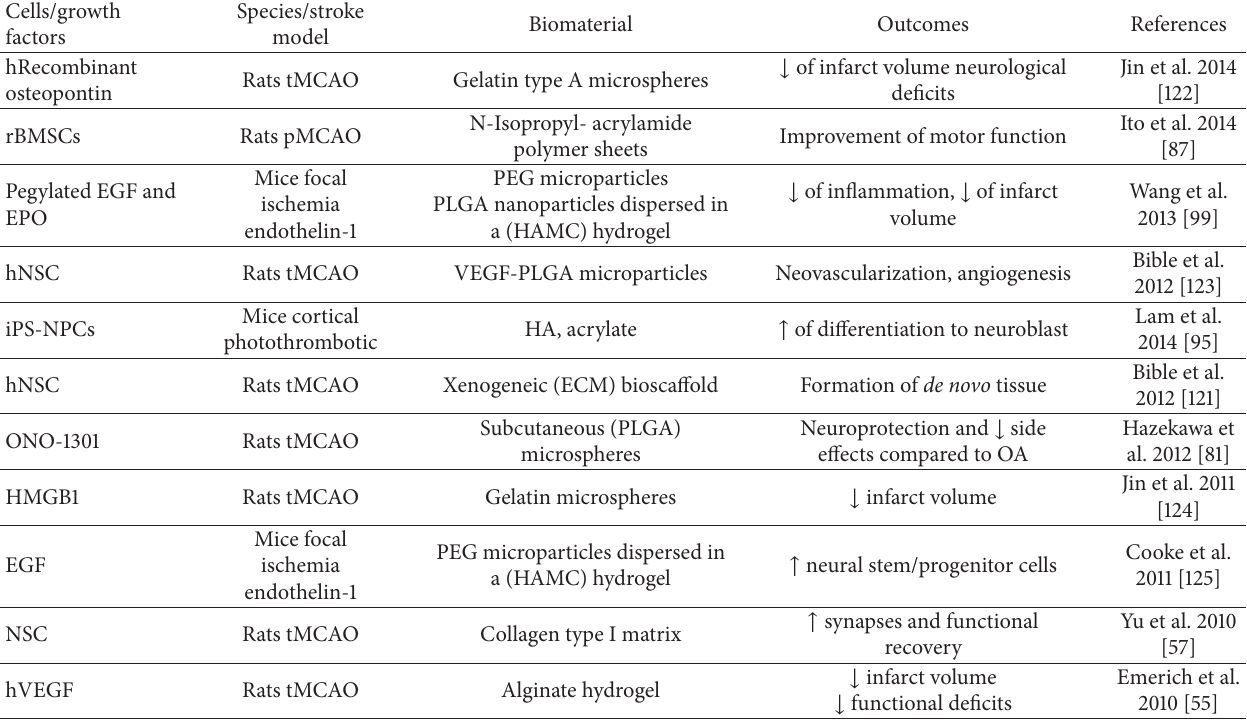
Table 1: Examples of biomaterials applications in experimental